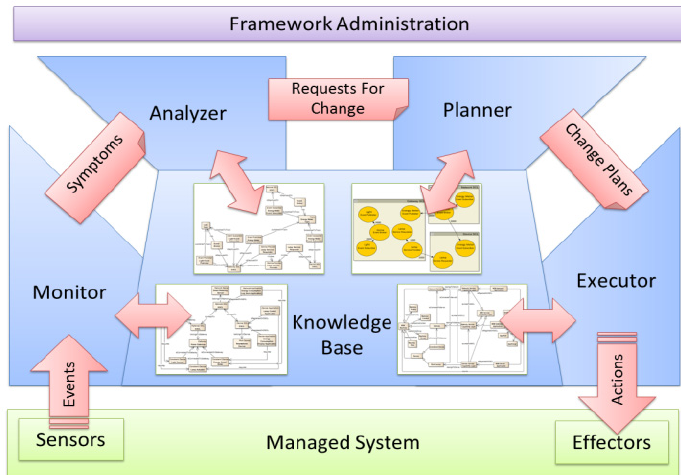
Figure 3. Autonomic M2M